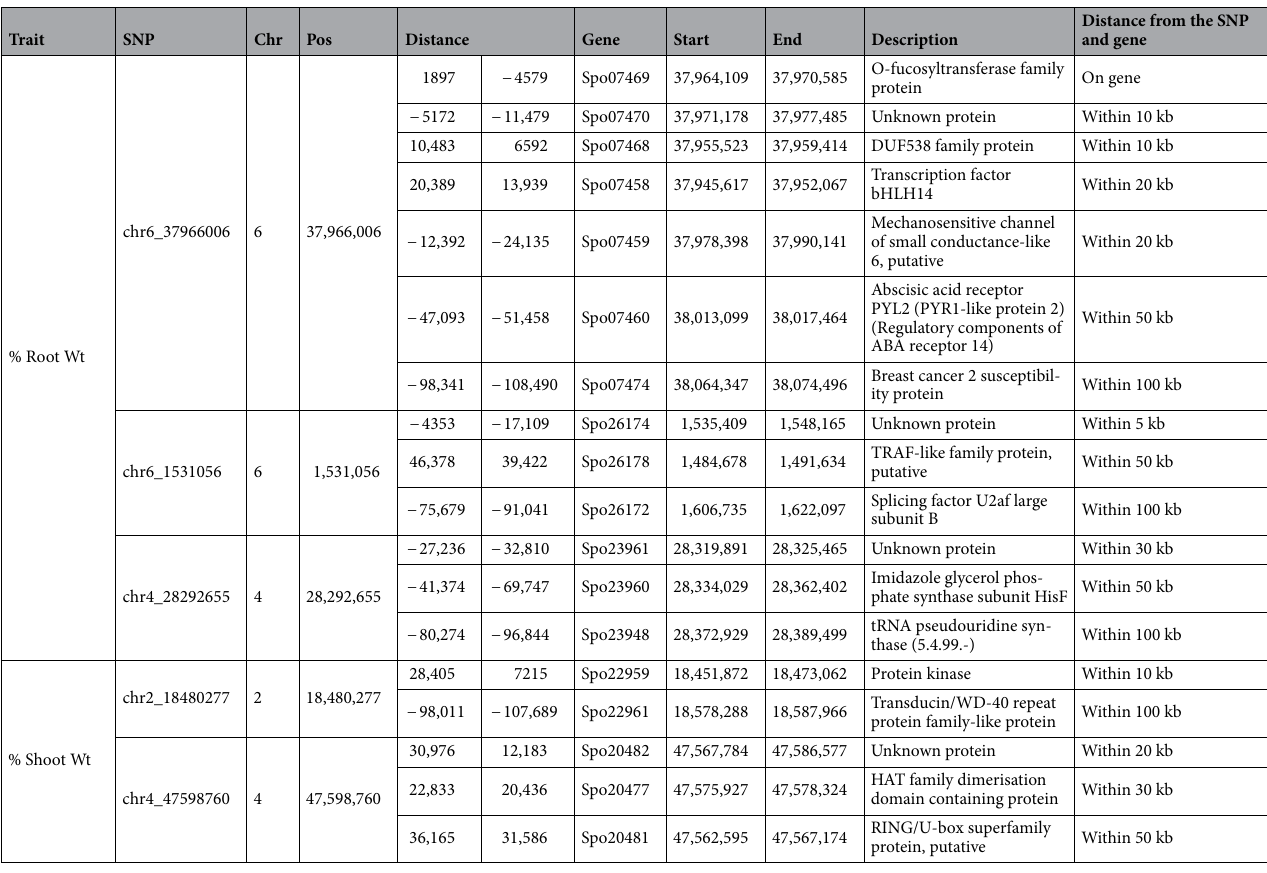
Table 2. List of candidate genes located at associated SNP regions for % change in root and shoot